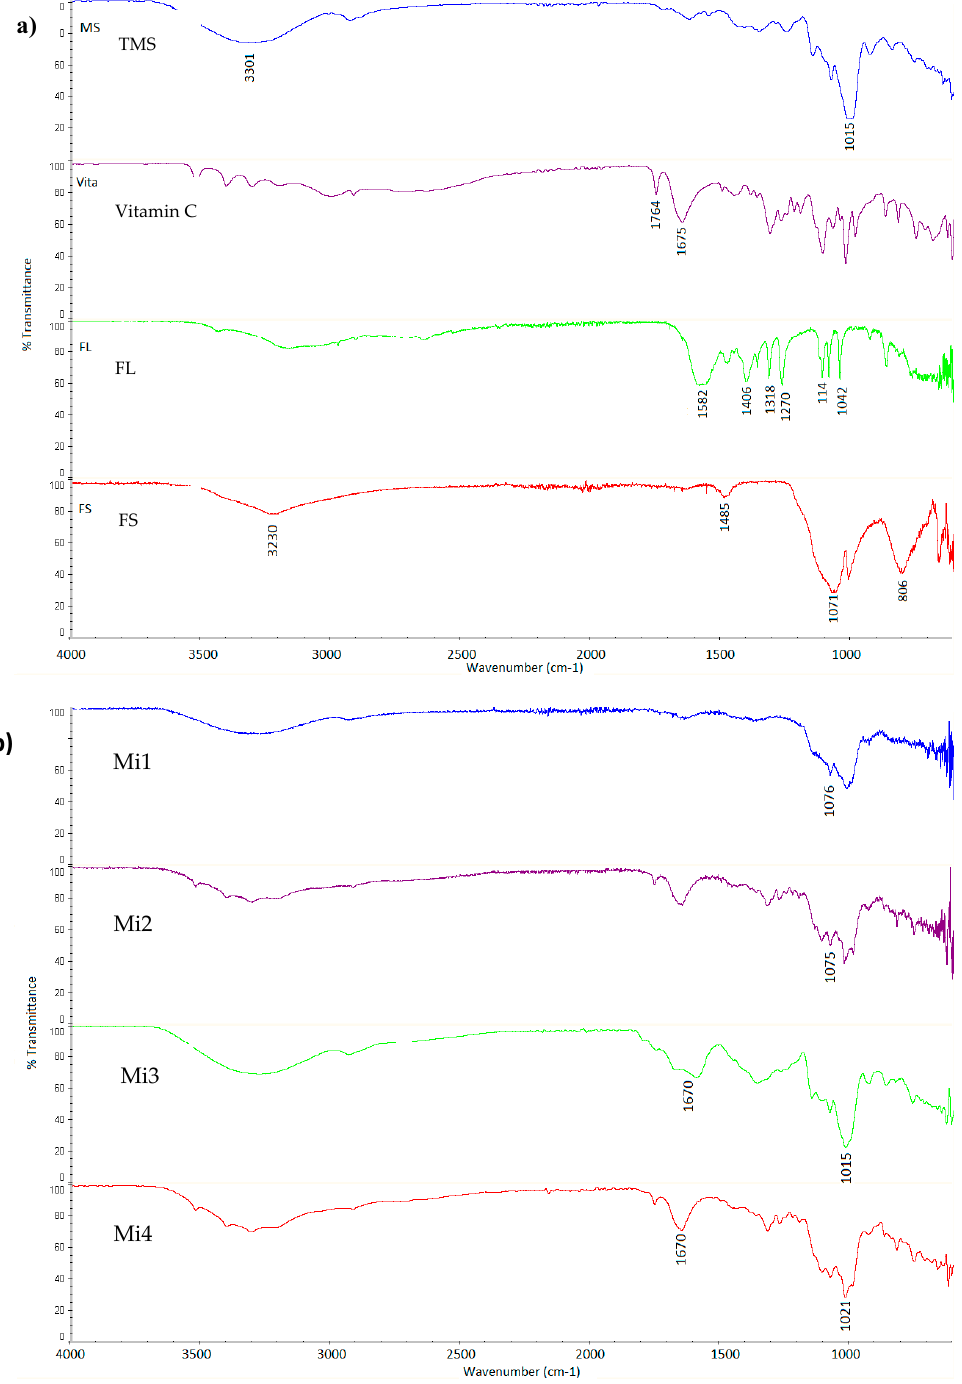
Figure 2. FTIR spectra for: ( a ) components used to build microcapsules (TMS—thermo-resistant modified starch; FS—ferrous sulphate; FL—ferrous lactate); and ( b ) preparations of iron encapsulated in thermo-resistant modified starch (Mi1—FS; Mi2—FS and Vitamin C; Mi3—FL; Mi4—FL and Vitamin